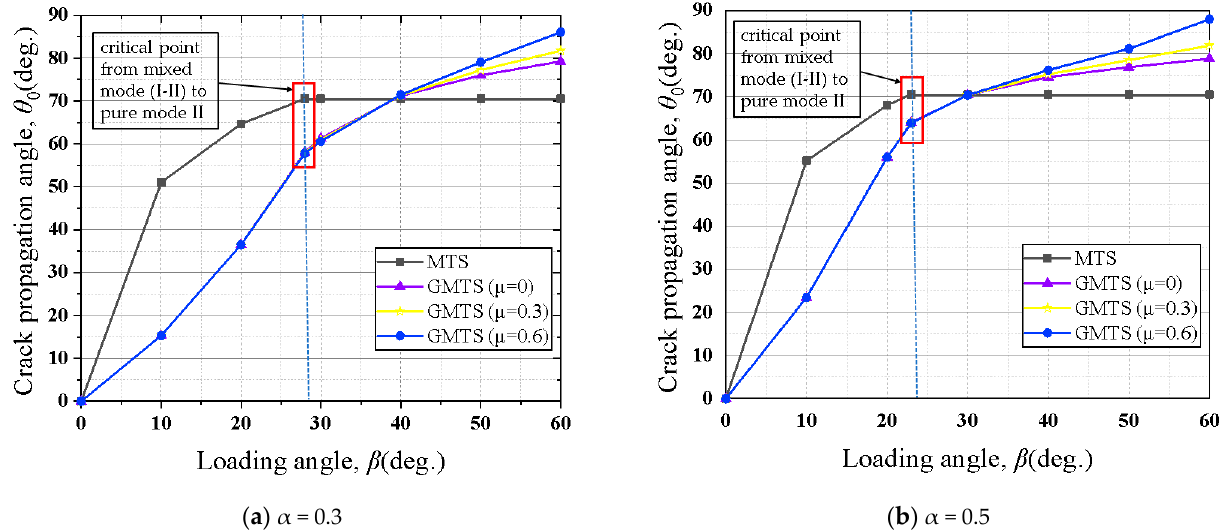
Figure 7. The crack propagation angle θ 0 versus the loading angle β with different relative crack lengths α . ( a ) α = 0.3, ( b ) α = 0.5.